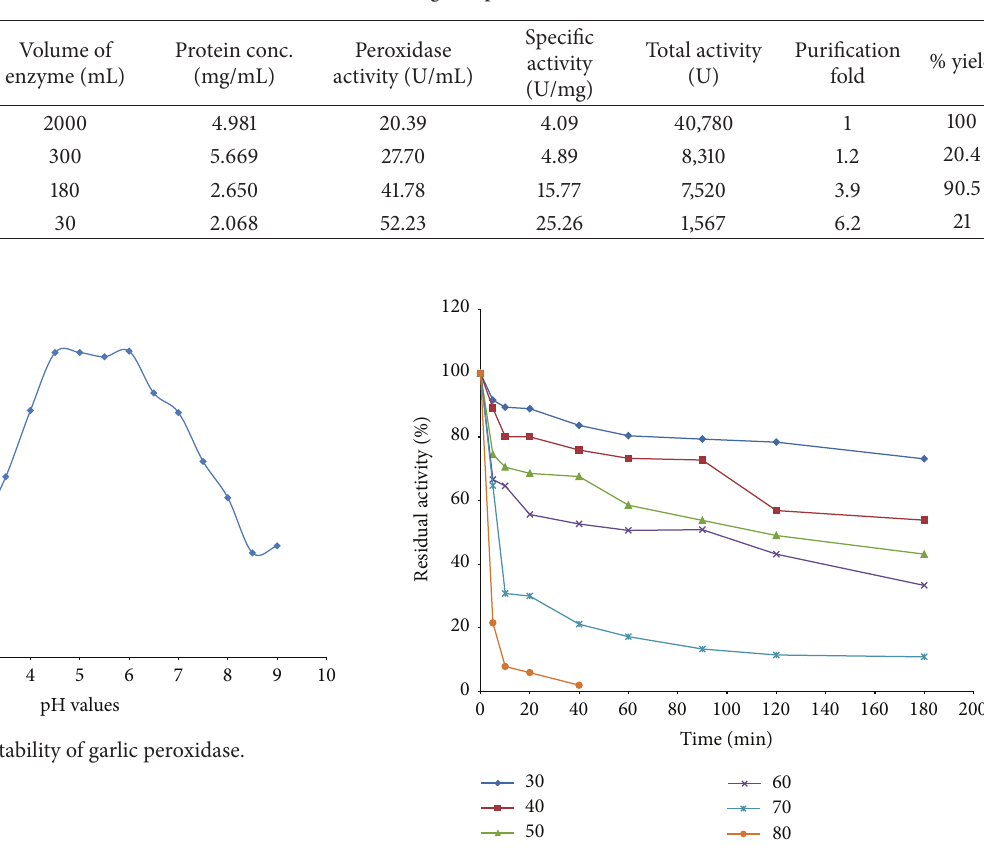
Figure 5: Heat stability of garlic